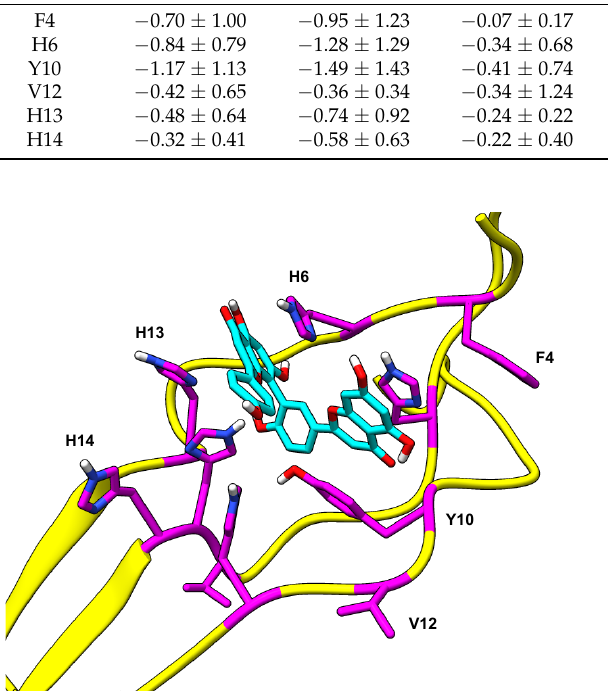
Figure 6. Amentoflavone in the N-terminal pocket of the A β 42 fibril being stabilized by F4, H6, Y10, V12, H13, and H14. This image is representative of the π - π interactions that were observed in the other biflavonoid simulations.